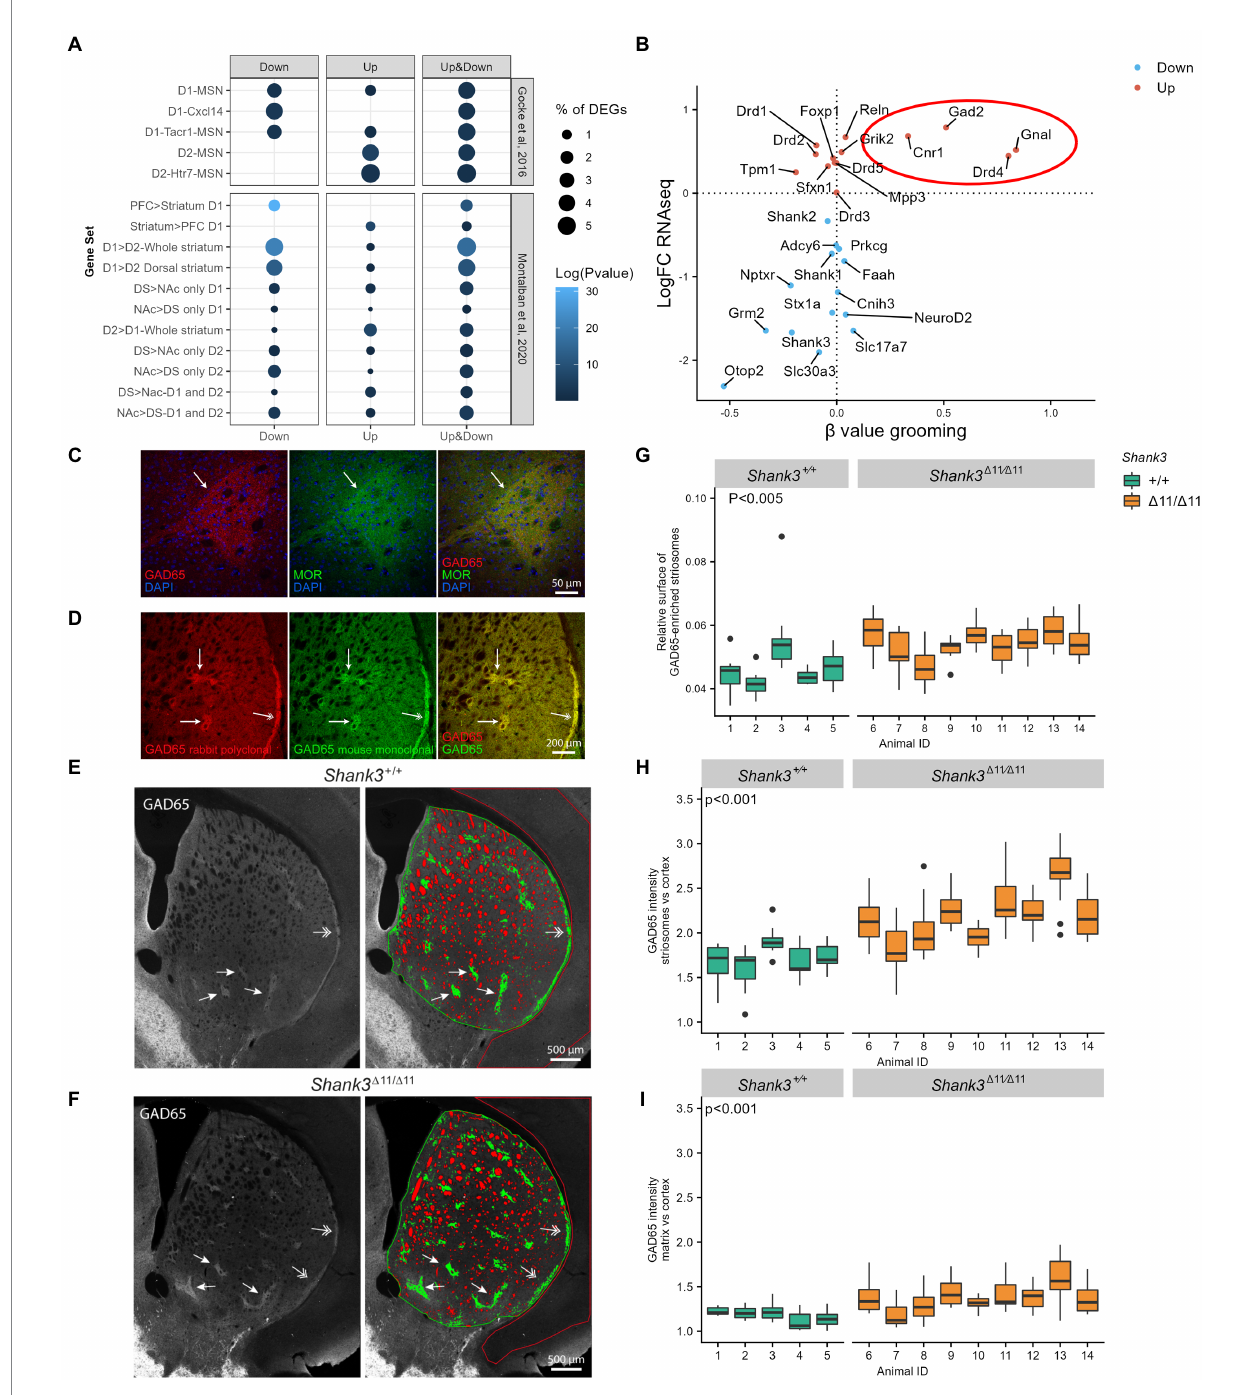
FIGURE 3 Altered transcriptome of D1- and D2-MSN, over-expression of GAD65, and modification of the striosome/matrix balance in the striatum of Shank3 Δ 11/ Δ 11 mice. (A) Enrichment of RNAseq DEGs in the striatum of Shank3 Δ 11/ Δ 11 mice compared to cell-specific gene clusters suggested by Gokce et al. (2016) and Montalban et al. (2020). Genes under-expressed in Shank3 Δ 11/ Δ 11 striatum are enriched in D1-MSN clusters while genes over-expressed in Shank3 Δ 11/ Δ 11 striatum are enriched in D2-MSN clusters. Ratio genes correspond to the proportion of DEGs enriched in the cluster. Over-representation analyses were performed with Fisher’s hypergeometric tests and p -values were adjusted for multiple testing with the Benjamini–Hochberg procedure within each category of DEGs. (B) Comparison of the log of the fold change of gene expression of selected genes in Shank3 Δ 11/ Δ 11 vs. Shank3 +/+ mice (LogFC RNAseq, Y axis) and the β values (slope of the linear regression) for low self-grooming vs. high self-grooming ( β value grooming, X axis). (C,D) Confocal images of striatum coronal sections of one-year old Shank3 +/+ male mice. (C) GAD65 immunoreactivity (red) is enriched in striatal microzones identified as striosomes by immunostaining for μ -opioid receptor (MOR, in green), a canonical marker of striosomes. (D) Increased GAD65 immunoreactivity in striosomes (arrows) and subcallosal streak (two-headed arrows) compared to surrounding matrix is observed with two different antibodies: the rabbit polyclonal antibody (Invitrogen PA5-77983 in red) used in (C,E,F) and a mouse monoclonal antibody (Millipore MAB351, in green). (E,F) Distribution and quantification of GAD65 immunoreactivity in dorsal striatum sections of a Shank3 +/+ (E) and a Shank3 Δ 11/ Δ 11 (F)